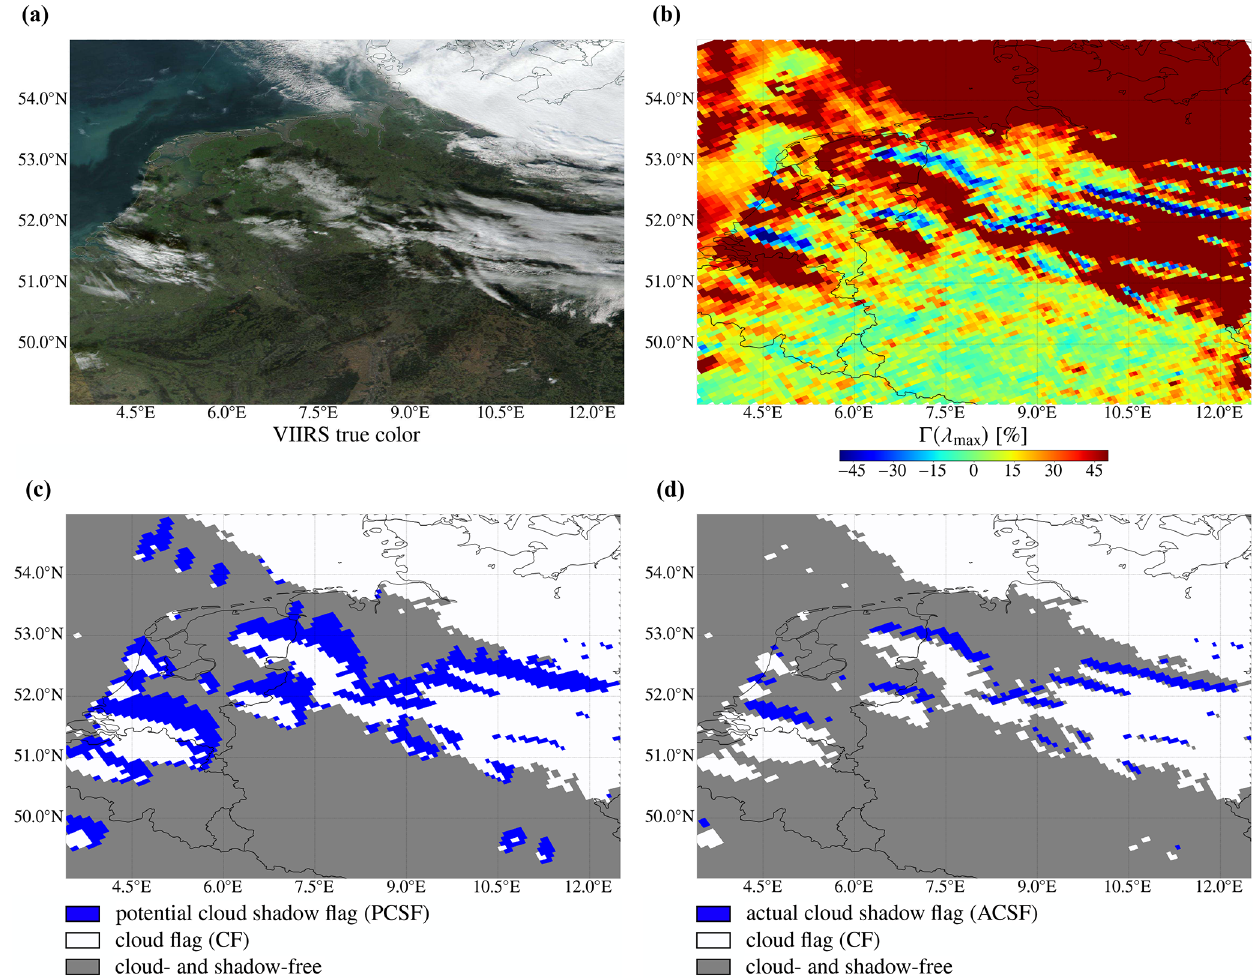
Figure 8. VIIRS-NPP true-colour image (a) , SCNLER–DLER contrast parameter (cid:48) at λ max measured by TROPOMI (b) and TROPOMI Level 2 UVIS ground pixels with raised PCSFs (c) and with raised ACSFs (d) , for the Netherlands and Germany on 18 November 2018. In (c, d) white pixels are cloud pixels, and grey pixels do not contain a raised cloud or shadow